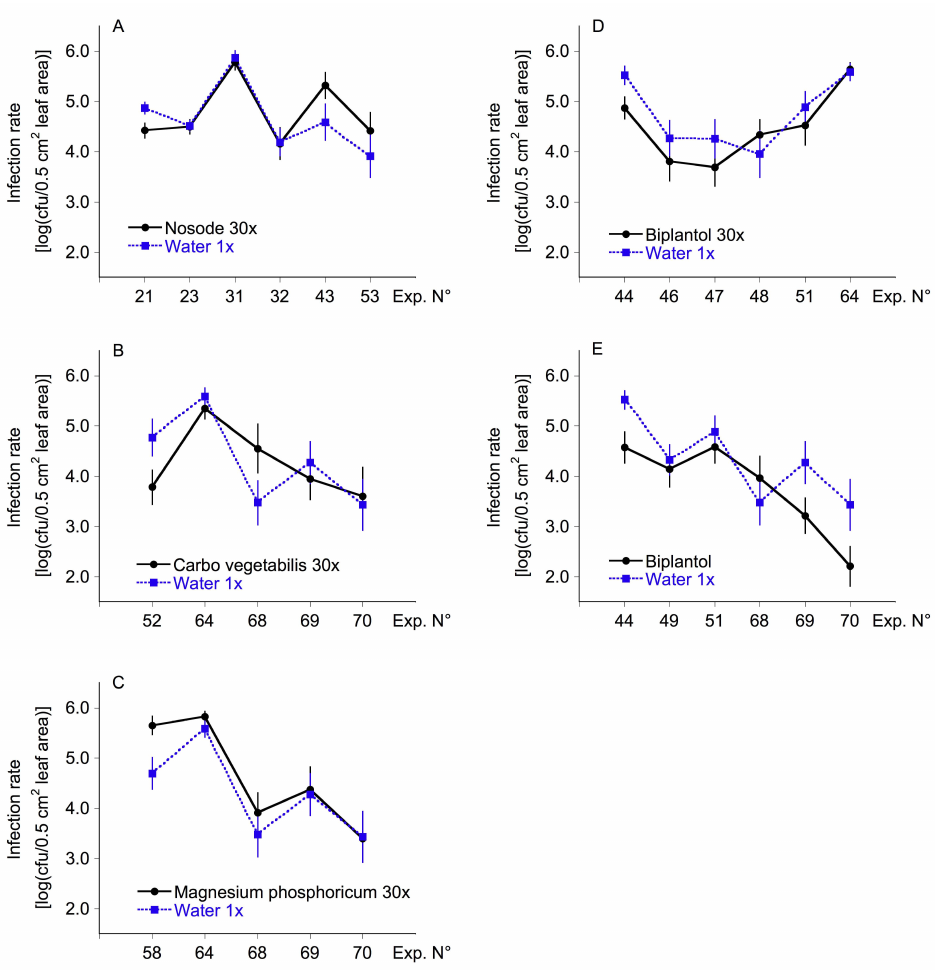
FIGURE 1. Number of bacteria of P. syringae in leaves of A. thaliana treated with different homeopathic preparations (A) Nosode 30x; (B) Carbo vegetabilis 30x; (C) Magnesium phosphoricum 30x; (D) Biplantol 30x; (E) Biplantol (in original formulation) or succussed water (1x) as control, as a function of independently performed experiments logarithm of the number of colony forming units per 0.5 cm 2 leaf area, mean ± standard